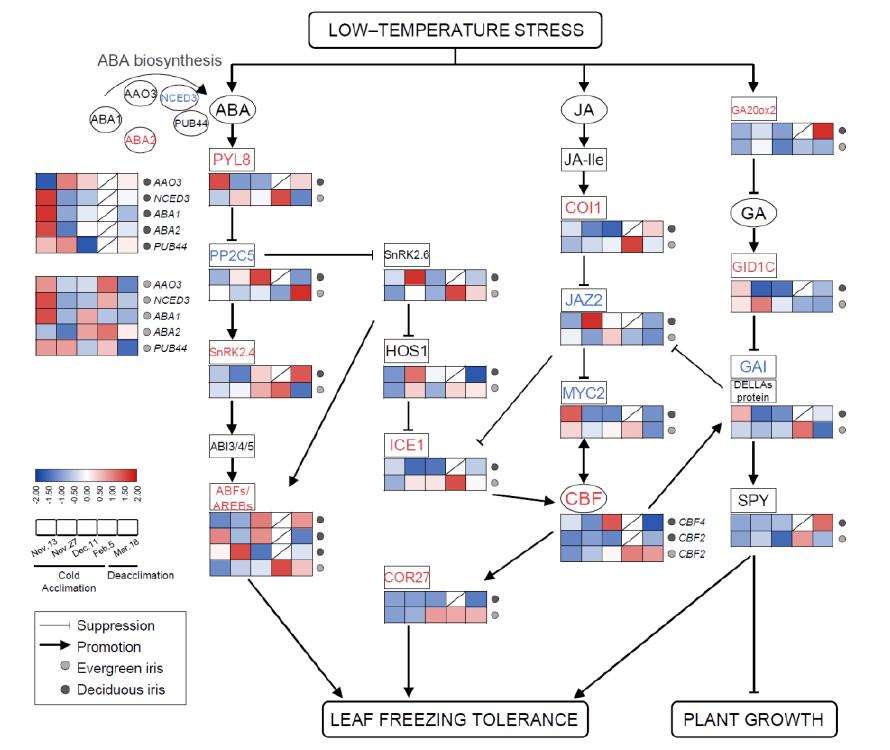
Figure 6. The involvement of plant phytohormone signaling in responses to cold stress and the expression levels of related genes in functional leaves of evergreen and deciduous irises. CBF s can be directly modulated by key components of JA signaling pathways. ABA and GA signaling are thought to facilitate improvements in freezing tolerance in irises, mainly by participating in the ICE–CBF–COR cascade. Arrows indicate promotion, whereas lines ending with a bar suggest suppression. Cold acclimation process, sampling from 13 November to 5 February 2021; deacclimation process, sampling from 19 February to 18 March 2021. Gene names are presented in Table S2.